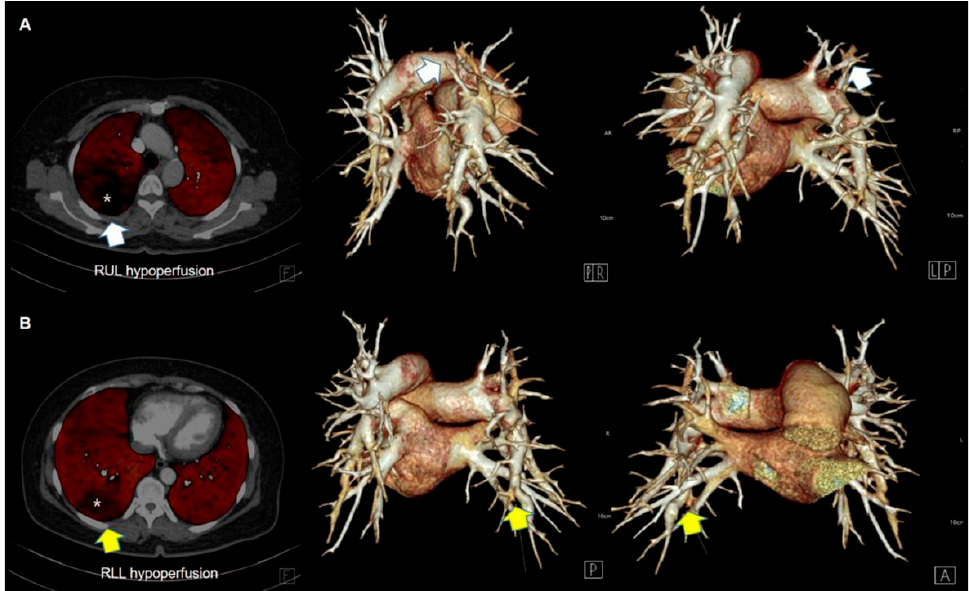
Figure 7. PBV maps and corresponding 3D volume rendering images of pulmonary arteries in a CTEPH patient. PBV maps demonstrate perfusion defects (regions marked with an asterisk) in the right upper lobe (RUL) ( A ) and right lower lobe (RLL) ( B ). Three-dimensional volume rendering images demonstrate attenuation and occlusion of corresponding vessels.